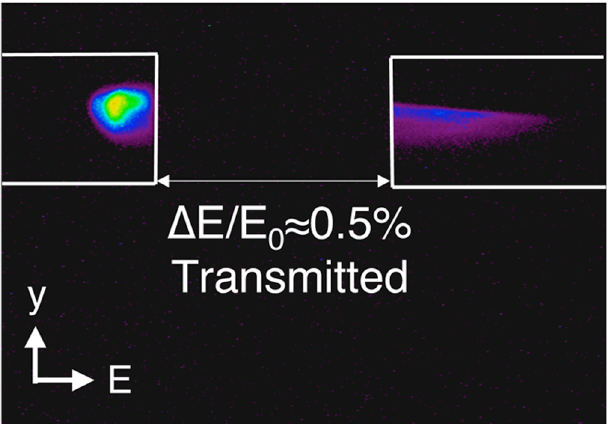
FIG. 5. (Color) Raw video image of the beam at the energy slit ( s ¼ 10 : 8 m in Fig. 1) looking downstream from the electron gun. The part of the beam visible on the picture is intercepted by the slit. The slit jaws are indicated by the white rectangles. The transmitted energy range is j (cid:1) E=E 0 j (cid:1) 0 : 5% around the E 0 ¼ 58 MeV average energy.